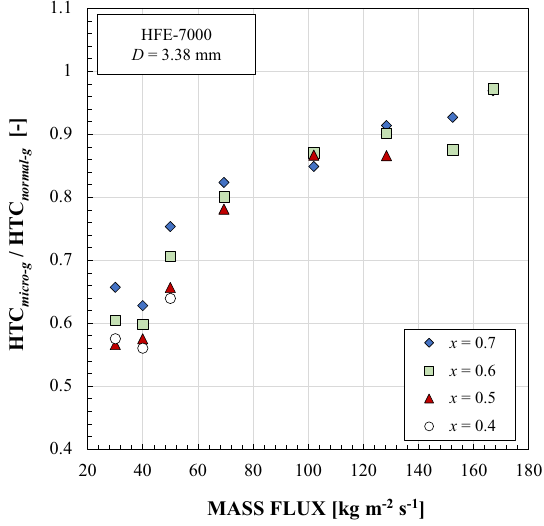
Fig. 2 In-tube condensation heat transfer penalization under microgravity. Ratio of the experimental condensation heat transfer coef fi cient in microgravity to the one obtained in normal gravity conditions with HFE-7000 inside a 3.38 mm inner diameter channel at different mass fl uxes G [kg m − 2 s − 1 ] and in the vapor quality x range from 0.4 to 0.7 (Berto et al. 28